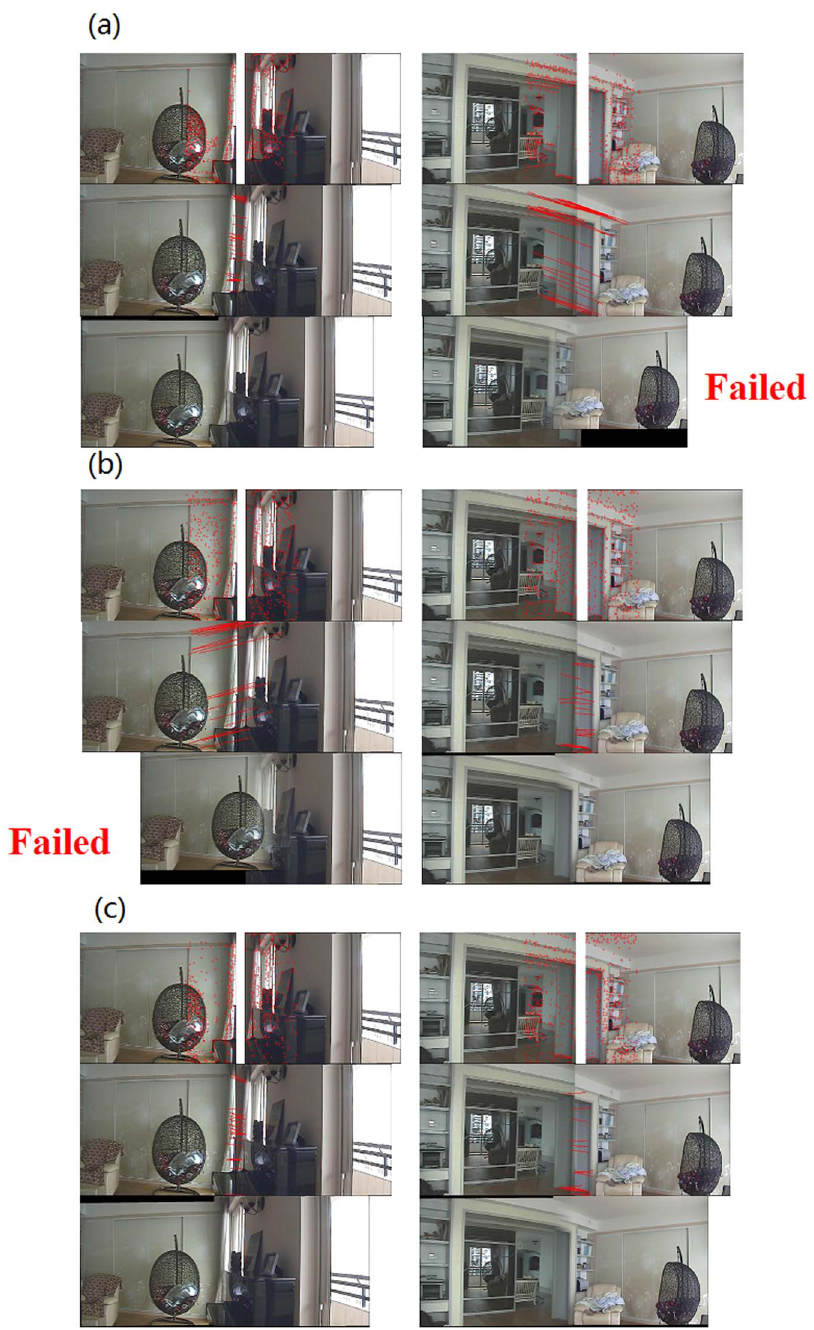
Figure 6. Comparison of stitching results from three different algorithms (I): (a) Traditional Harris detector; (b) The regional corner- selection algorithm in [ 9 ] ; (c) Our presented algorithm.